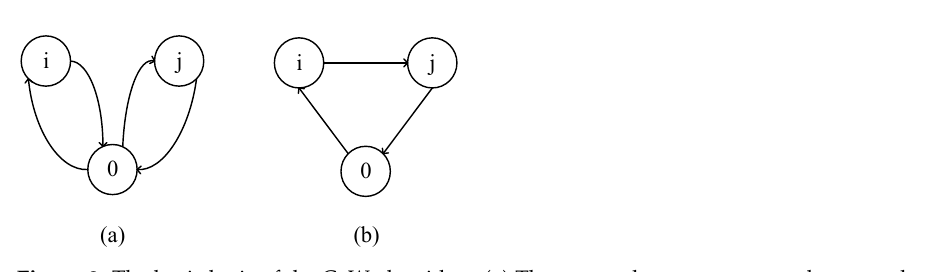
Figure 2. The basic logic of the C–W algorithm. ( a ) The two nodes are transported separately. ( b ) The two nodes are combined into a loop for transport.